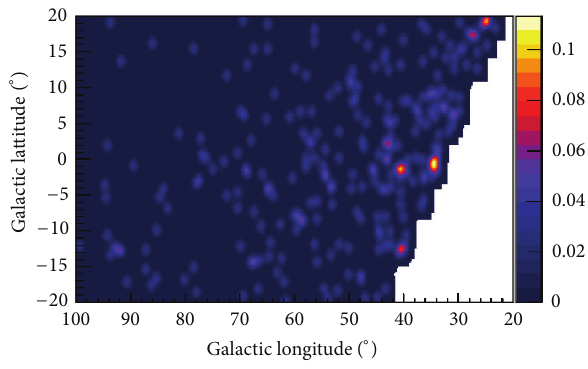
Figure 3: Simulated sky map of IceCube in Galactic coordinates after 5 years of operation of the completed detector. Two Milagro sources are visible with 4 events for MGRO J1852 + 01 and 3 events for MGRO J1908+06 with energy in excess of 40TeV. These, as well as the background events, have been randomly distributed accord- ing to the resolution of the detector and the size of the